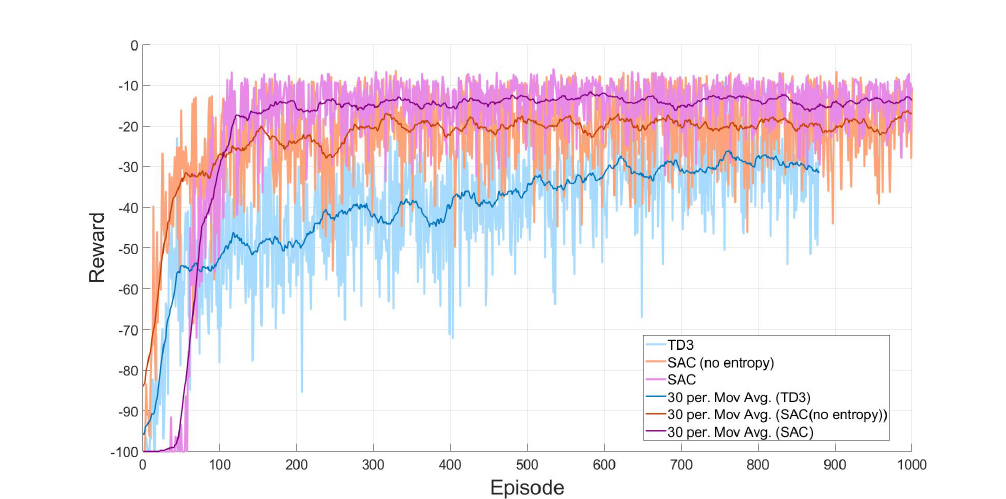
Figure 8. Comparison of the training performances between TD3 and